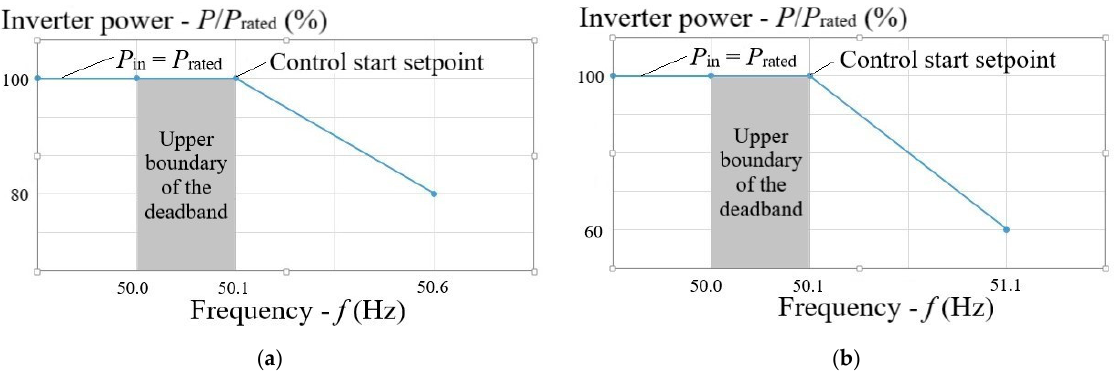
Figure 4. ( a ) A graph of testing the upper boundary of the deadband of the general primary frequency control; ( b ) a graph of power limitation by the inverter at f 1 = 50.2 Hz.